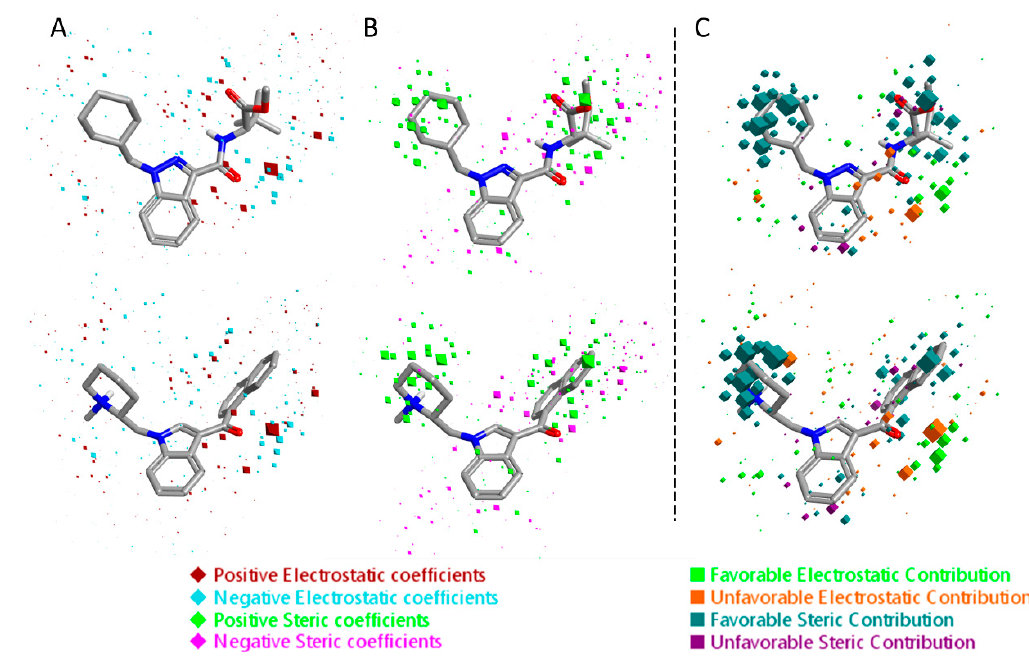
Figure 6. Electrostatic and steric coefficients for the CB 1 model. ( A ) Electrostatic coefficients superimposed to MDMB-CHMINACA (up) and AM-1220 (down). ( B ) Steric coefficients superimposed to MDMB-CHMINACA (up) and AM-1220 (down). ( C ) Contributions to predicted affinity for MDMB-CHMINACA (up) and AM-1220 (down).